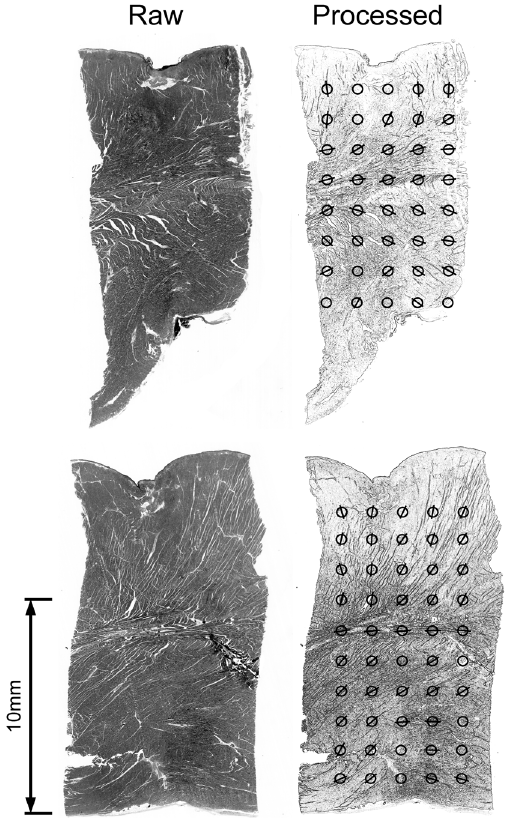
Figure 6. Two representative stained histological sections using haematoxylin-eosin of normal myocardium from differ- ent sites in the Ovine left ventricle. Left: unprocessed image. Right: convolved images identifying transmural anisotropy vectors in two dimensions from multiple sites indicated (circles) within each section. Circles arranged from epicardium (top) to endocardium (bottom). Anisotropy vectors orientated vertically at epicardial layer with distinct transitioning to horizontal orientation at the mid myocardial layer followed by diagonal orientation at the endocardial layer.